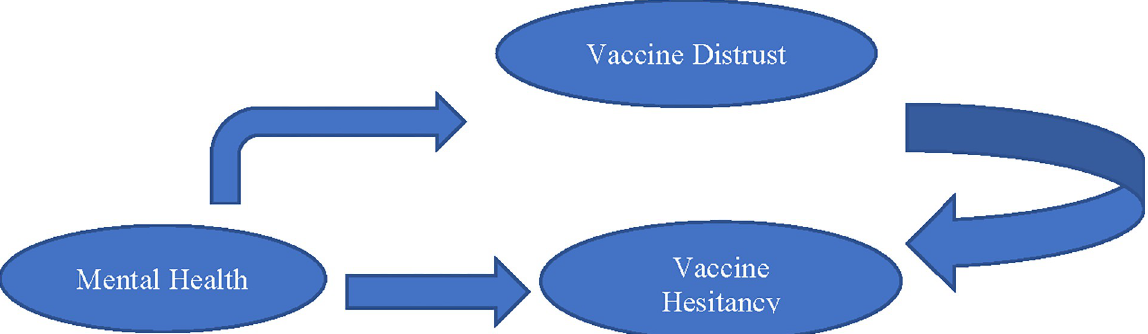
Fig 1. Relationship between mental health, vaccine distrust and vaccine